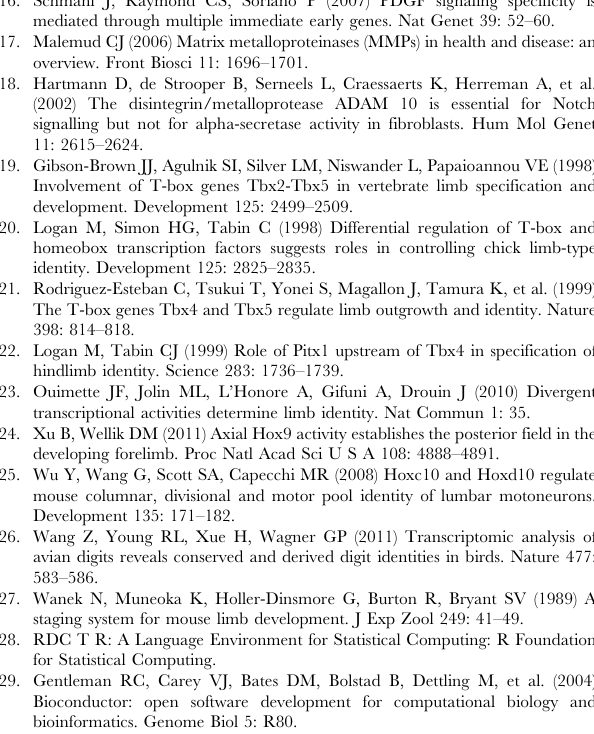
Table S3 Clusters of Differential Gene Expression. Table S4 Stage-specific enriched genes. Table S5 Forelimb and Hindlimb up-regulated